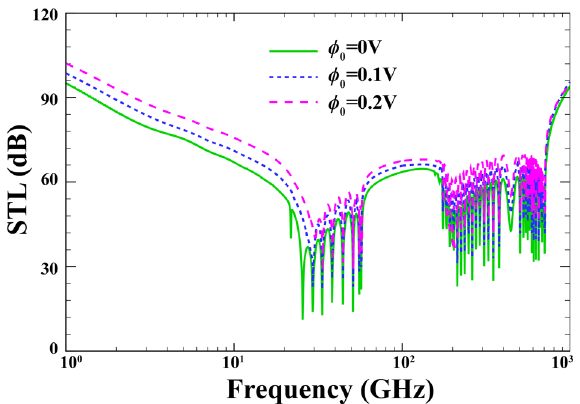
Figure 10. Effect of the initial electric potential on the changes of STL.